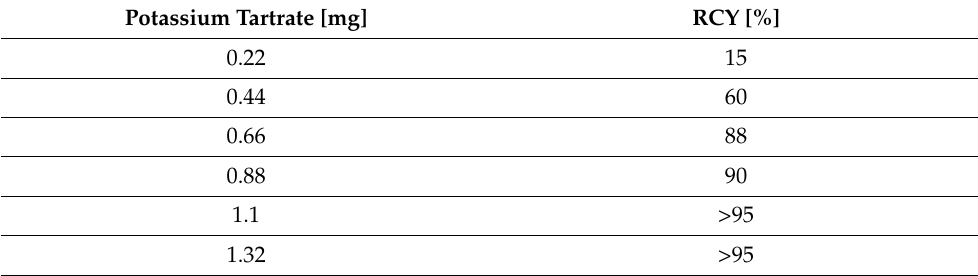
Table 3. Radiochemical yield of [ 99m Tc]Tc-tartrate intermediate complex relative to the amount of potassium tartrate.